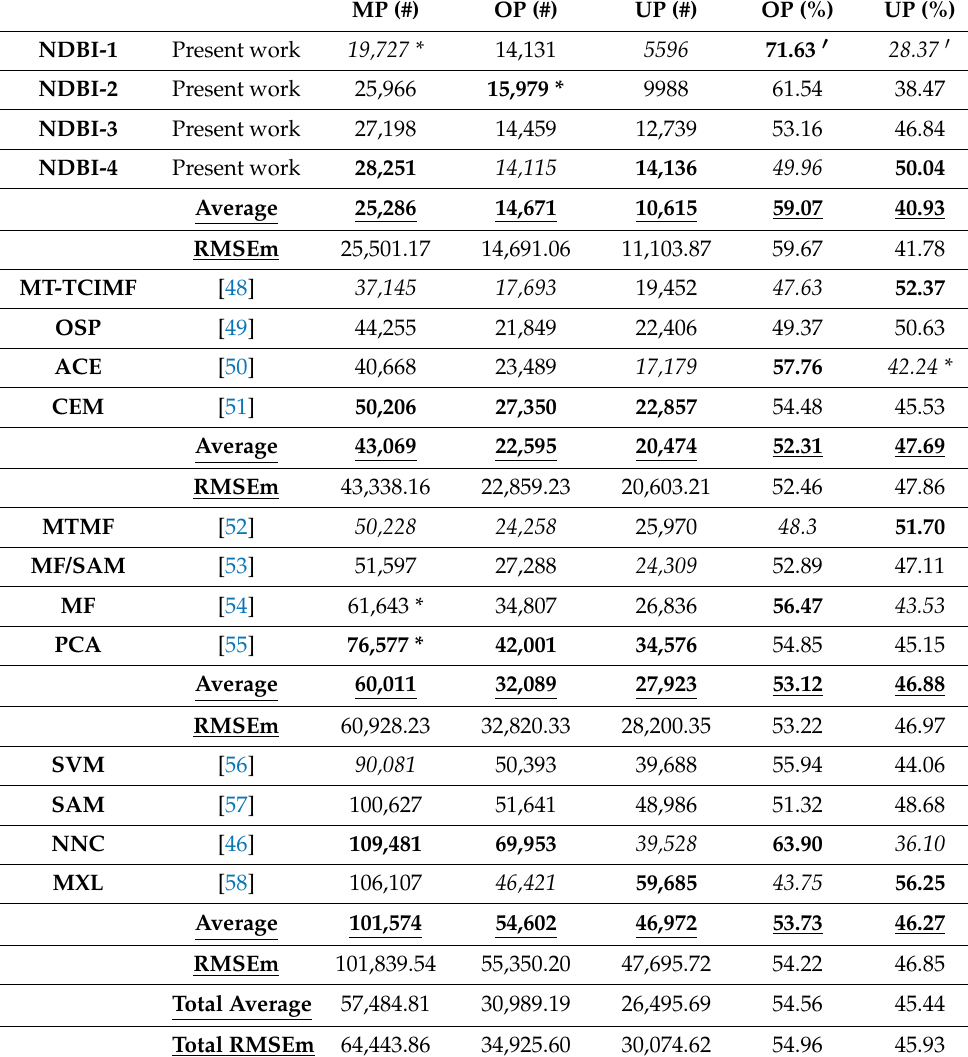
Table 6. Quantitative evaluation (misclassified number of pixels, % and #) of various feature extraction methods for extracting blue ice from the 12 analysed tiles. The lowest (italics) and highest (bold) values in each local column are highlighted. The column-wise total and average values are bolded and underlined. [MP: Misclassified Pixels, OP: Overestimated pixels, UP: Underestimated pixels]. Global outliers (w.r.t. the 16 methods) are highlighted with ( (cid:48) ) and local outliers (w.r.t. the four methods in each respective approach) are highlighted with